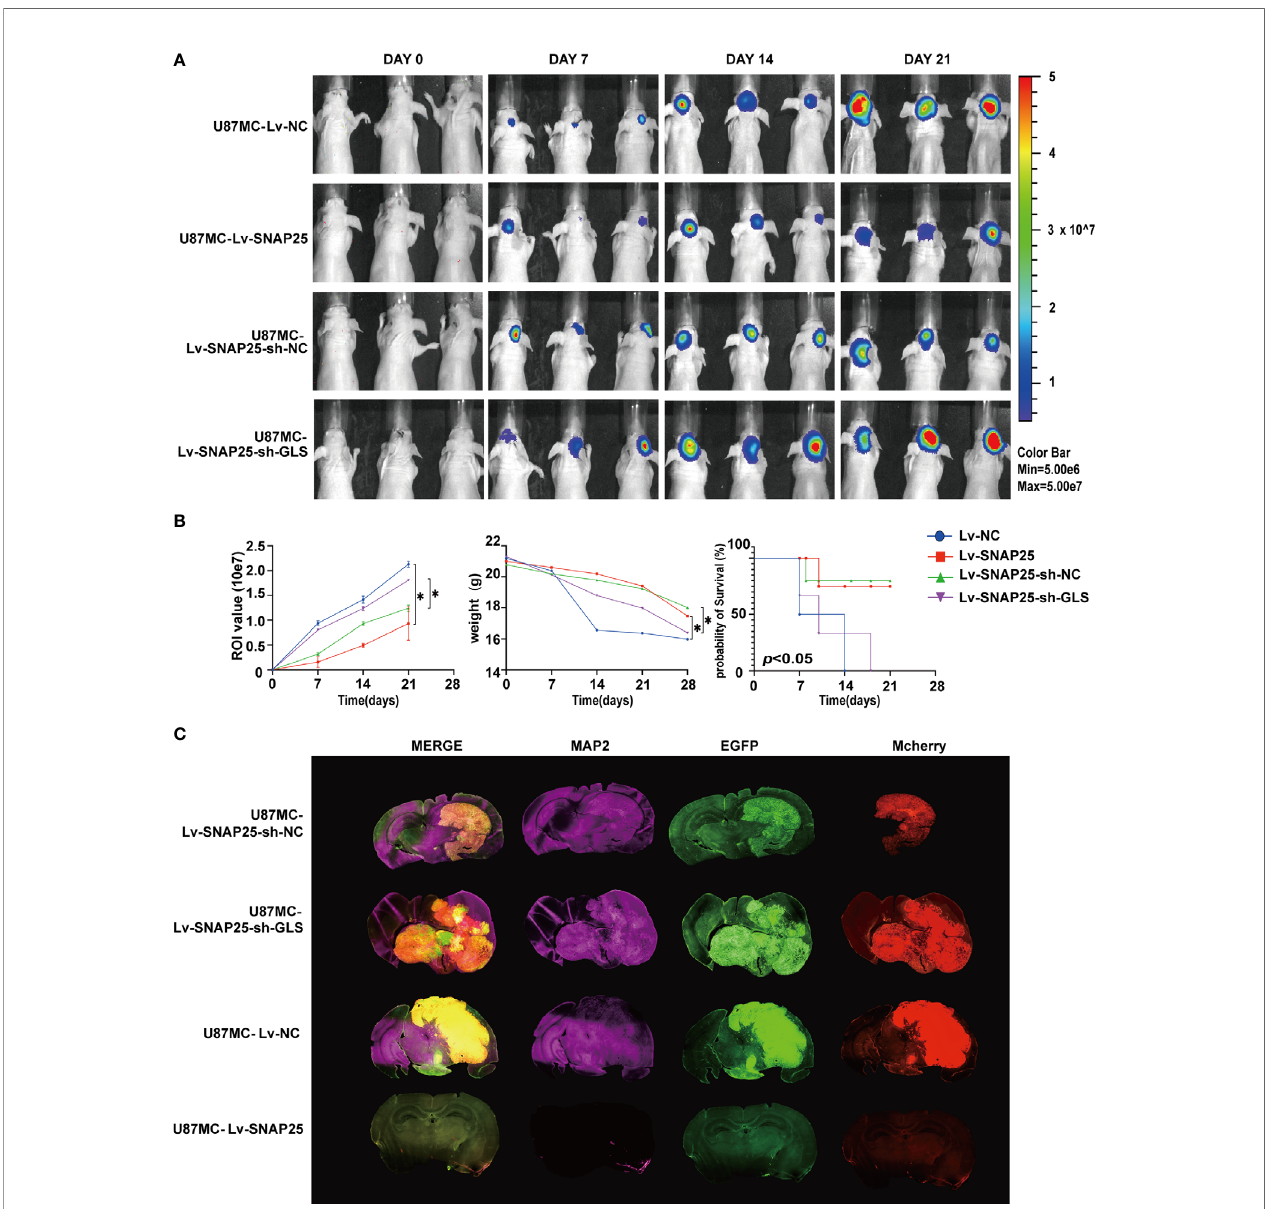
FIGURE 7 | (A) Tumor growth was monitored over time (up to Day 21) by measuring luciferase emission (ROI). (B) The ROI value, weight of the mice and the probability of survival was recorded over time. * p < 0.05 compared with Lv-NC or Lv-SNAP25-sh-NC group. (C) Glioma cell (Mcherry staining) and neuronal dendron (MAP2 staining) in the brains of indicated mice at the time of harvesting (Day